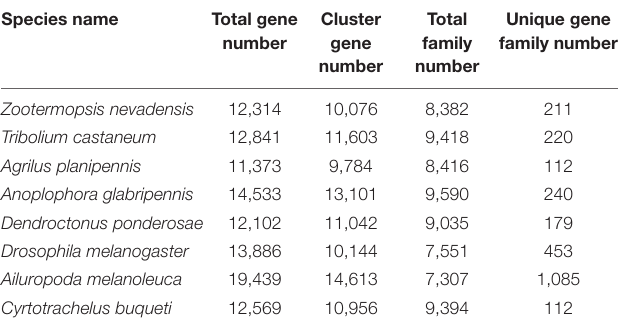
TABLE 3 | Comparative genomic analysis of the eight species.